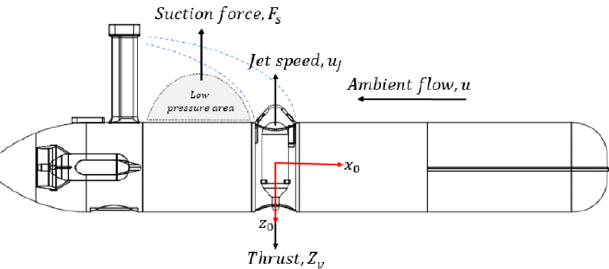
Figure 6. Interaction between the jet of the vertical tunnel thruster and the ambient